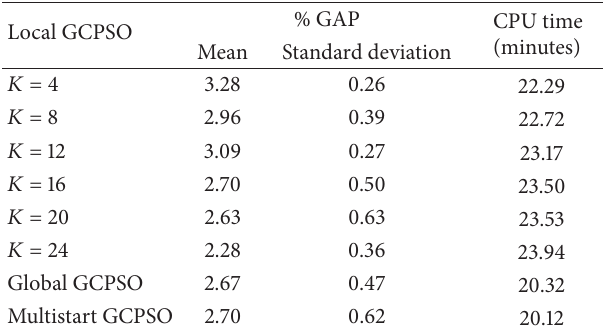
Table 5: Numerical results of different variants of the GCPSO algorithm in the case of problem